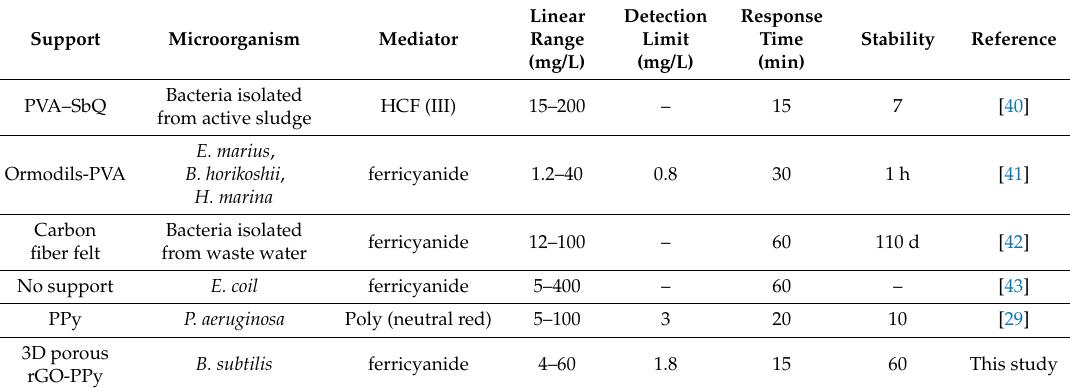
Table 3. Comparison to other mediated BOD approaches from previous